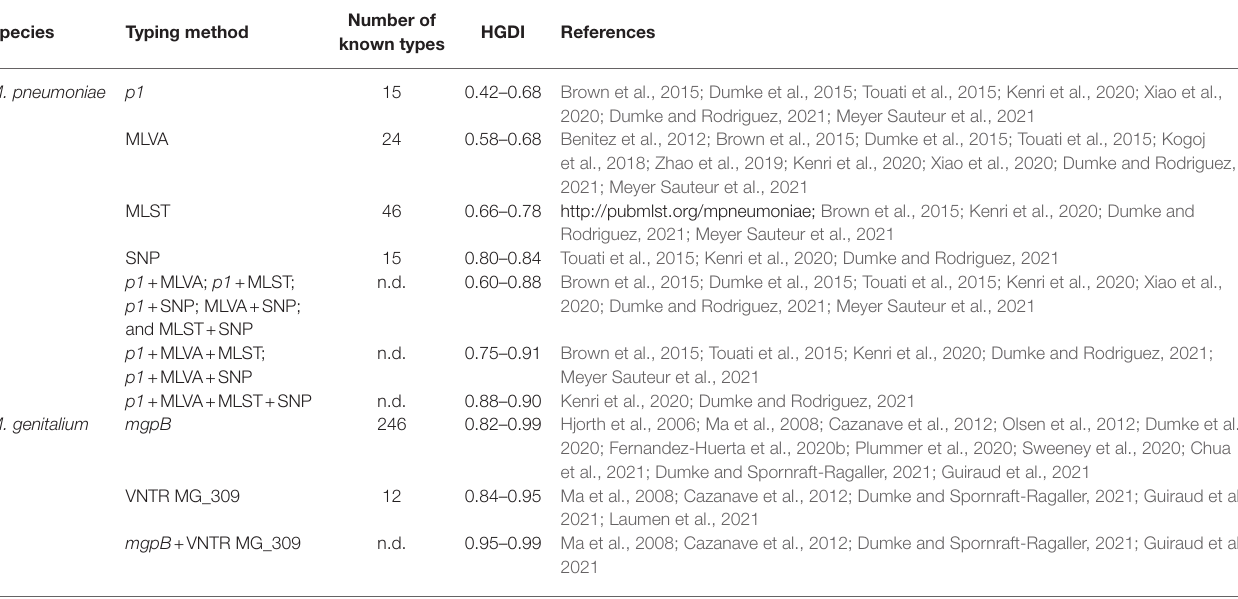
TABLE 1 | Characteristics of frequently used molecular approaches for typing Mycoplasma pneumoniae and Mycoplasma genitalium (results of studies with >25 patients are included; if not presented in the study, HGDI’s are calculated according to the data).